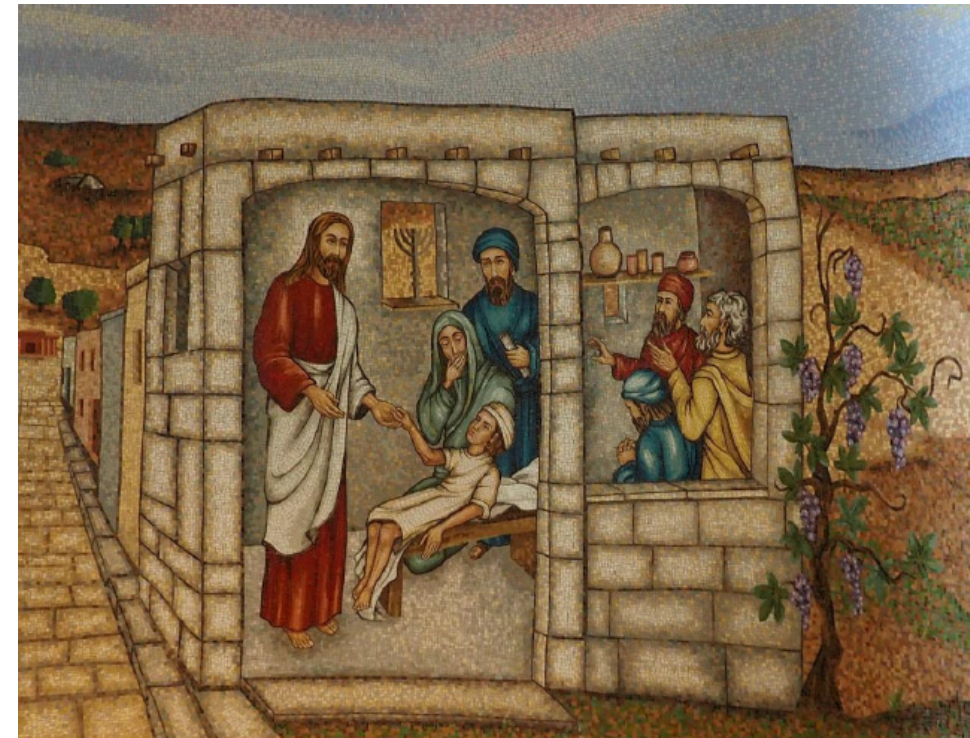
Figure 8. Detail: Talitha qum with Menorah (photo: Assaf Pinkus). The opposite chapel, in the southwest, depicts Christ Driving Out the Seven Demons from Mary Magdalene (Figure 9). Standing on two flat rocks against a barren mountainous background, Christ is pointing toward Mary Magdalene. Local flora, such as olive trees, a palm, the agave plant, and several flowers, suggest a rather conventional symbolism. Uniquely, an amaryllis flower is featured in the middle of the composition. Bearing a close similarity in its form to the Marian lily, yet colored in a deep red symbolizing fleshly passion, it perfectly illustrates the dual nature of Mary Magdalene: sanctity and sin (Mozley and Mozley 1852, pp. 45, 120). The red color of the amaryllis also recalls the unique coloring of Christ’s robe, suggesting the union (in spirit) of the two protagonists. Deep in the mountains to the left are several tiny colorful cubic houses, similar to the houses along the market street in the mosaic depicting the resurrection of Jairus’ daughter. Consequently, the suggestive transposition of the resurrection of Jairus’ daughter to Magdala—the city of Mary Magdalene where, one may assume, her exorcism had taken place—is completed and becomes almost explicit. Although the visual similarity is controversial, it is worth noting that Father Solana, the conceptualizer of the entire site, links the hands of God and Adam in the painting of the Creation of Man by Michelangelo in the Sistine Chapel, to the hands of Jesus and Mary in Magdala. In the Sistine Chapel, claims Father Solana, it is the creation of man; and in Magdala it is the recreation of woman because Jesus is giving her new life (García 2016, p. 194).